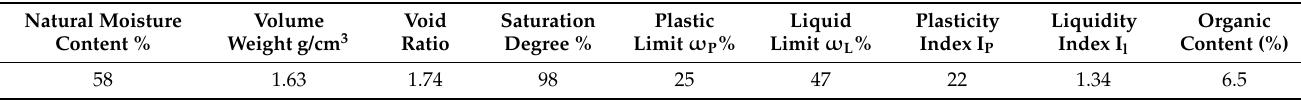
Table 1. Physical and mechanical indexes of coastal soft soil.